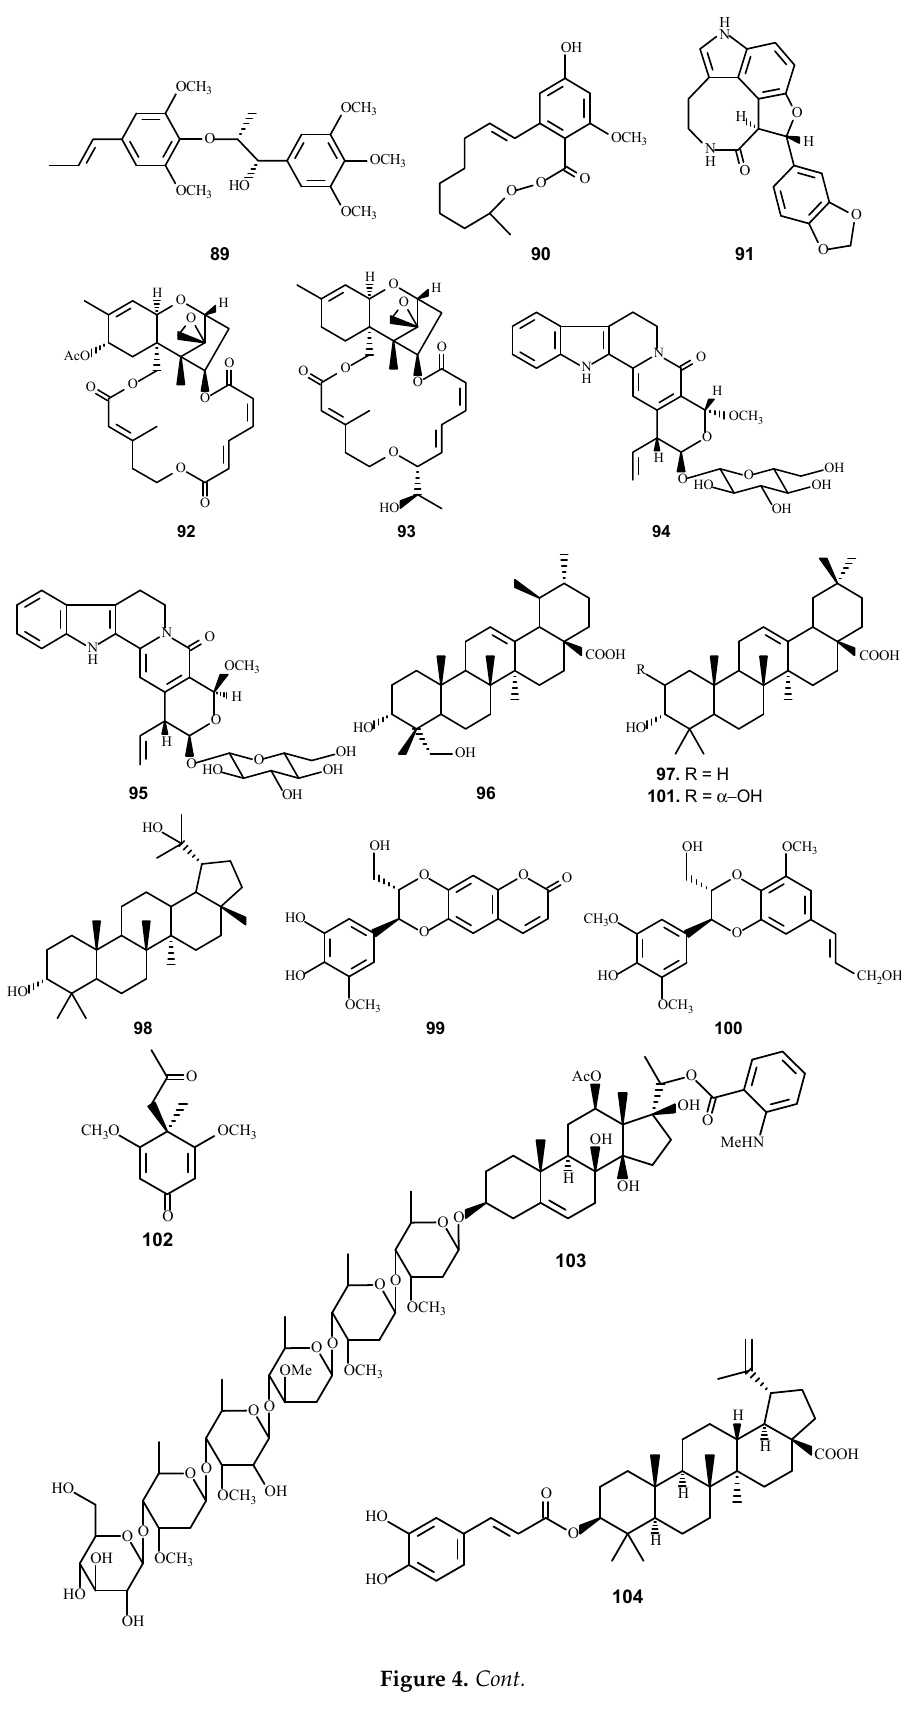
Figure 4. Cont. Figure 4.